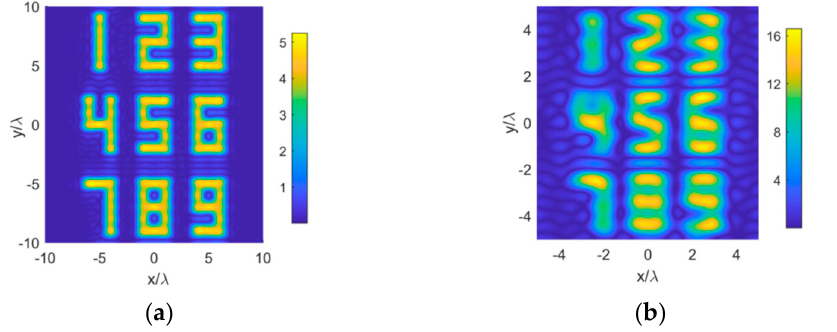
Figure 5. The results with smaller reconstruction areas. ( a ) Case 3; ( b ) Case 4.